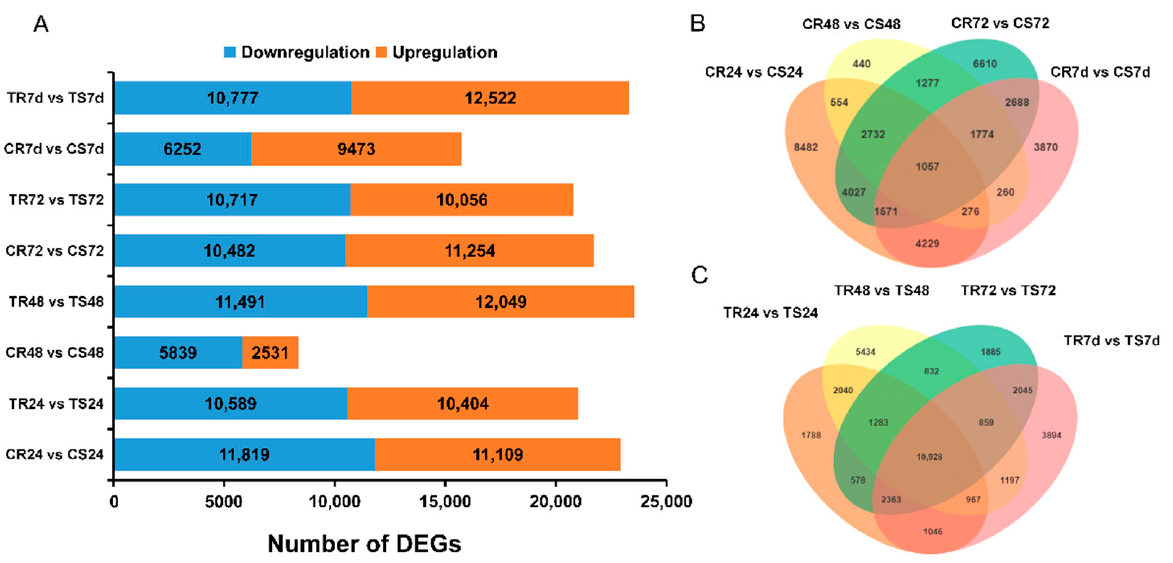
Figure 3. DEGs of uninoculated and inoculated groups in two lines. ( A ) The number of up- and downregulated DEGs between the uninoculated and inoculated groups. ( B ) A Venn analysis of DEGs between control groups at four time points. ( C ) Venn analysis of differentially expressed genes between inoculated groups at four time points. DEGs: differentially expressed genes; CS: uninoculated groups of susceptible clonal line; TS: inoculated groups of susceptible clonal line; CR: uninoculated groups of resistant clonal line; TR: inoculated groups of resistant clonal line.